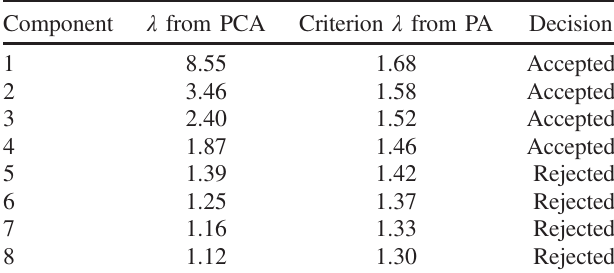
TABLE II. Comparison of PCA and PA factors. Component λ from PCA